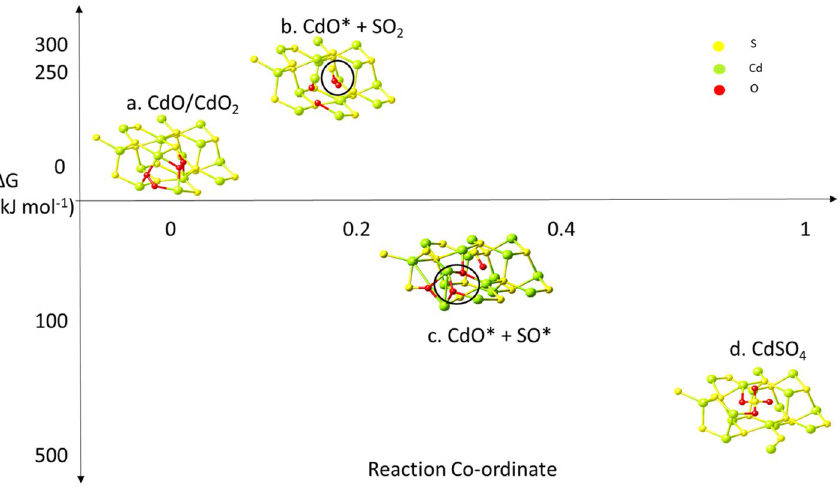
Figure 9. DFT Energy profile of CdO particles oxidizing into CdSO 4 . The black circles indicate the changes taking place in the reaction